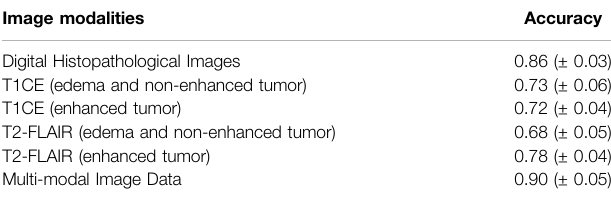
TABLE 3 | Prediction of IDH genotype based on high grade